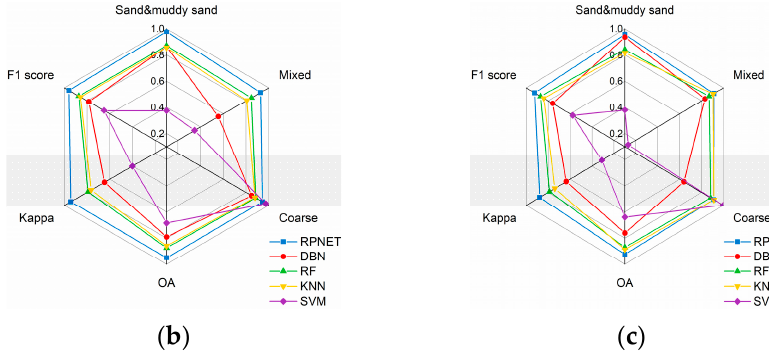
Figure 16. Comparison of different classifiers when the number of training samples decrease in